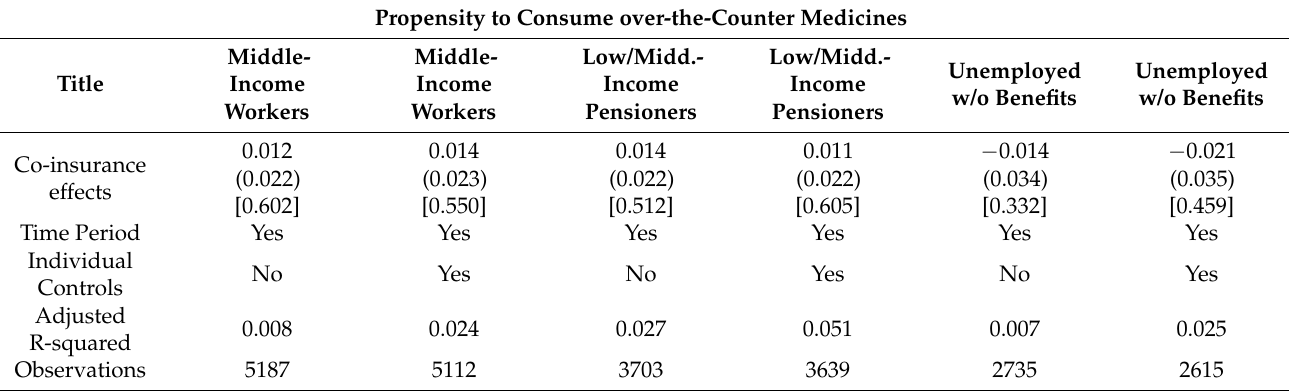
Table 6. Impact of the intervention on the propensity to consume OTC medicines. Propensity to Consume over-the-Counter